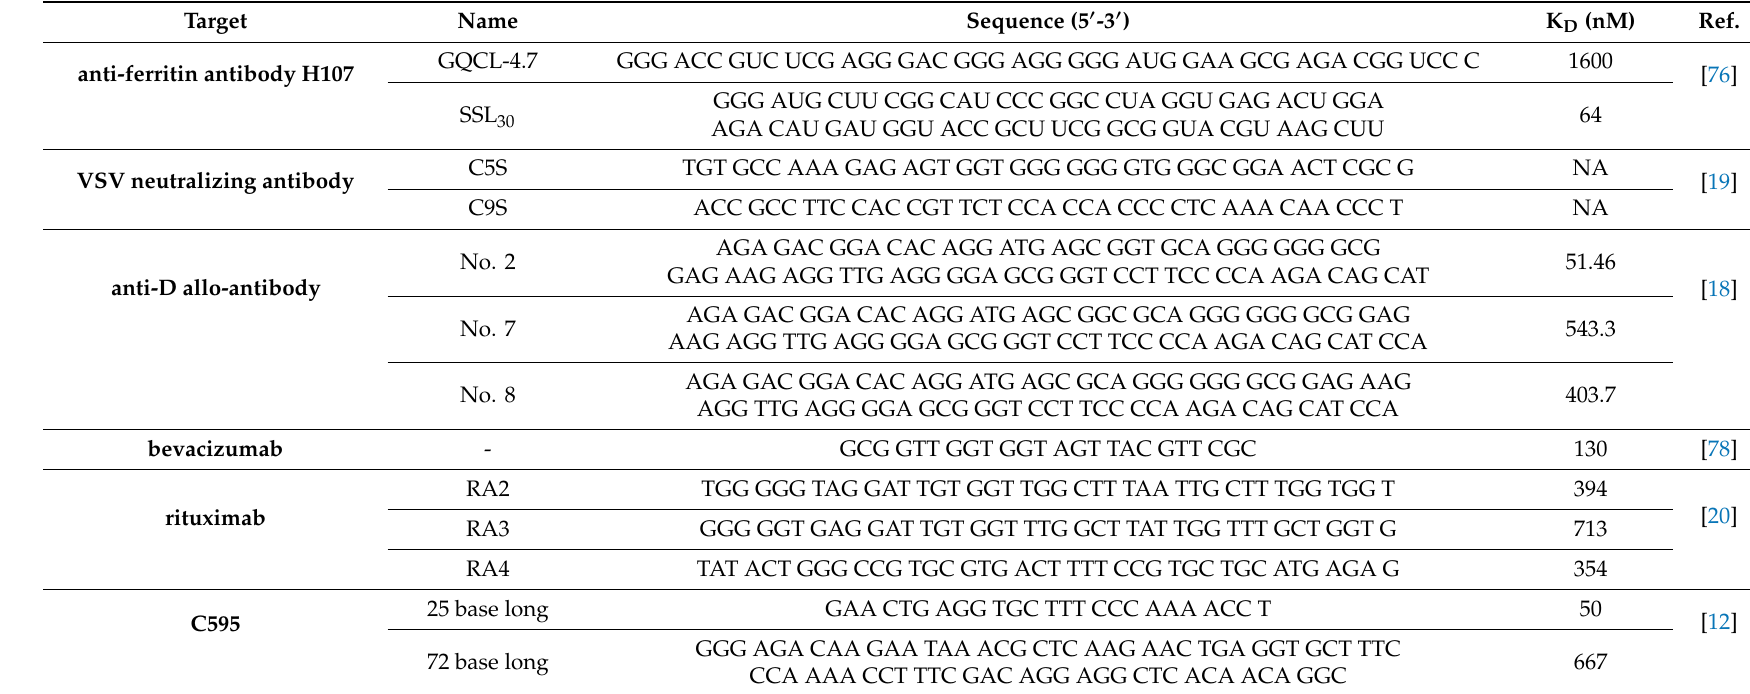
Table 5. Fab domain specific aptamers for di ff erent antibody targets with their sequences and K D